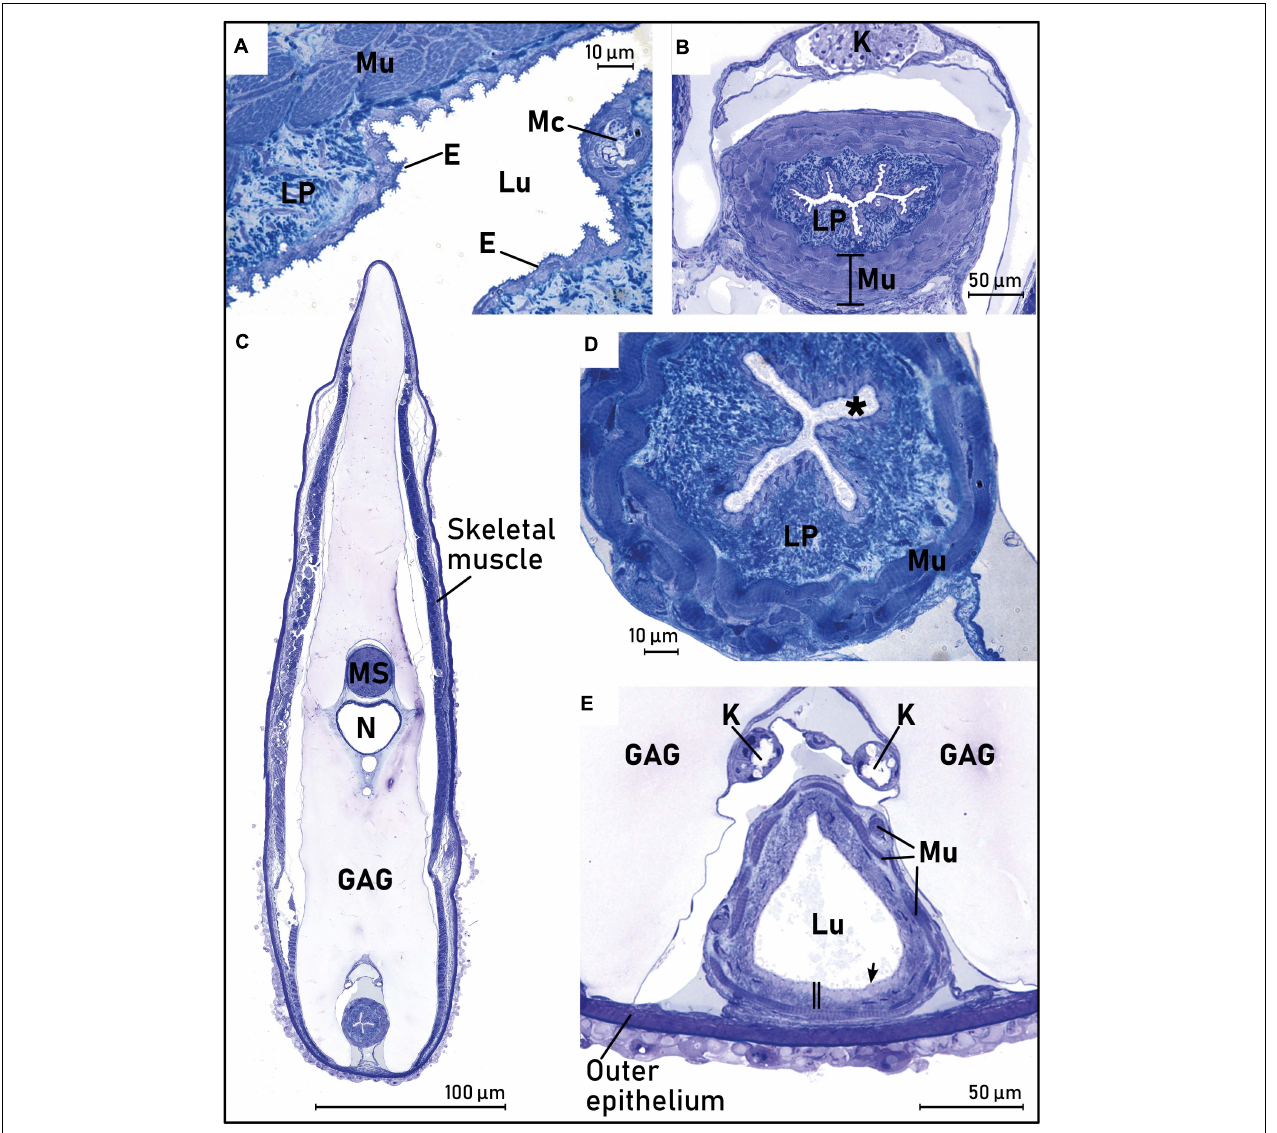
FIGURE 6 | Cross sections of the anterior esophagus (Eso) of the largest sampled leptocephalus larvae of the European eel ( Anguilla anguilla ) (L21, SL = 23.33), demonstrating the rapid changes in morphology that occurs along the anterior esophagus tissue. (A) Close up of the beginning of pharynx/esophagus, with the circular and longitudinal striated skeletal muscle layers (Mu) surrounding the rough, squamous surface epithelium (E), mucus cells (MC), and the beginning of a lamina propria (LP). (B) Section through the “head kidney” with glomerulus, Bowman’s space and nephric tubules (K), 200 µ m further behind (A) , with the multilayered striated muscle (Mu) and a rough surface epithelium. (C) Overview 600 µ m behind (A) . (D) Close up of the larva in (C) , where the surface epithelium is now ciliated (*), the fibroelastic lamina propria (LP) is well developed, and the multilayered striated muscle (Mu) is organized into circular and longitudinal muscle bundles. (E) Overview 800 µ m behind (A) , with a larger lumen (Lu), ciliated surface epithelium (arrow), the lamina propria appeared thinner (vertical double line bar), and the striated muscle bundles are thinner and more fragmented. Abbreviations: *, ciliated surface epithelium; E, Epithelium; Eso, esophagus;